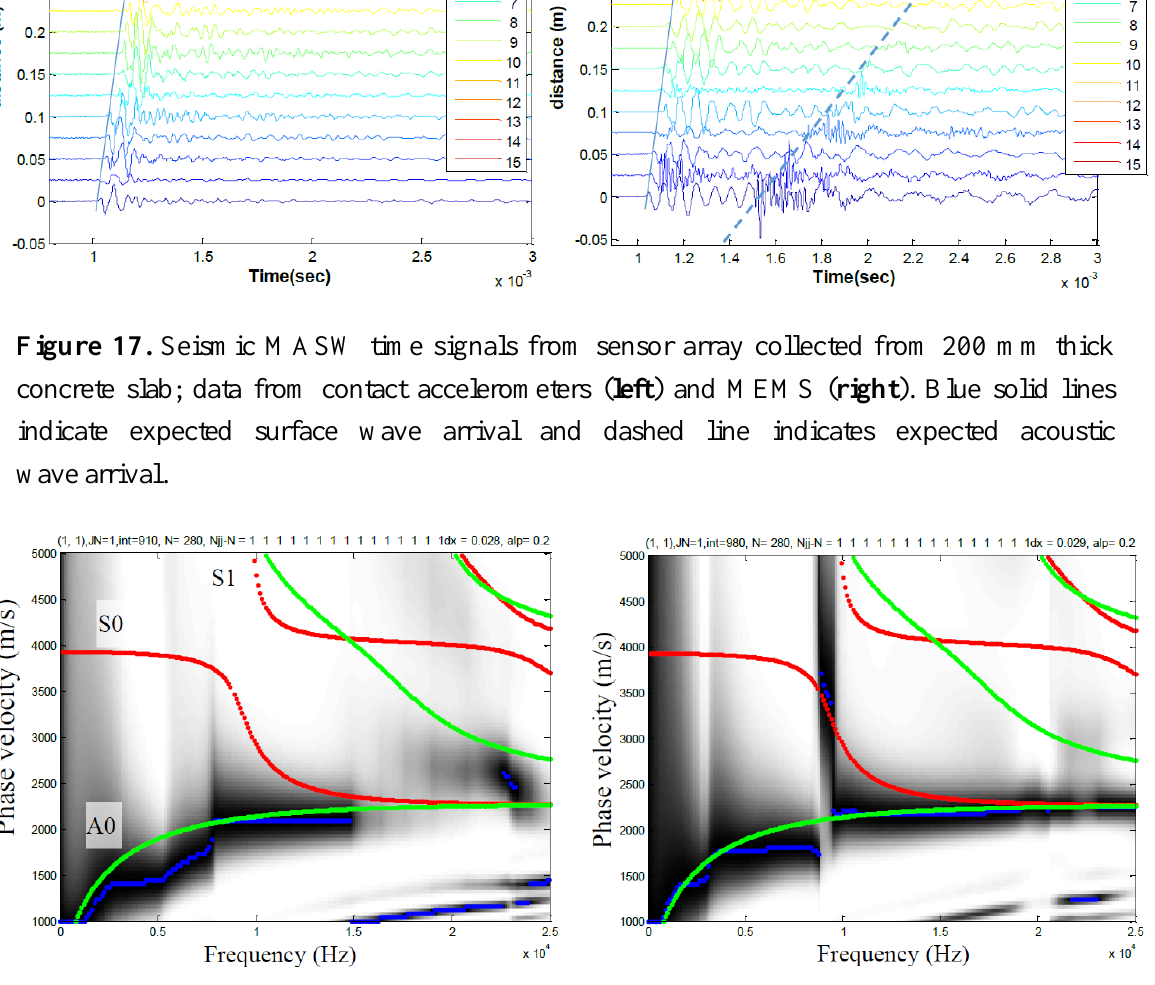
Figure 18. MASW dispersion curves computed from seismic time signals from 200 mm thick concrete slab; data from contact accelerometer ( left ) and MEMS sensors ( right ). Red and green lines indicate expected asymmetric and symmetric, respectively, Lamb wave